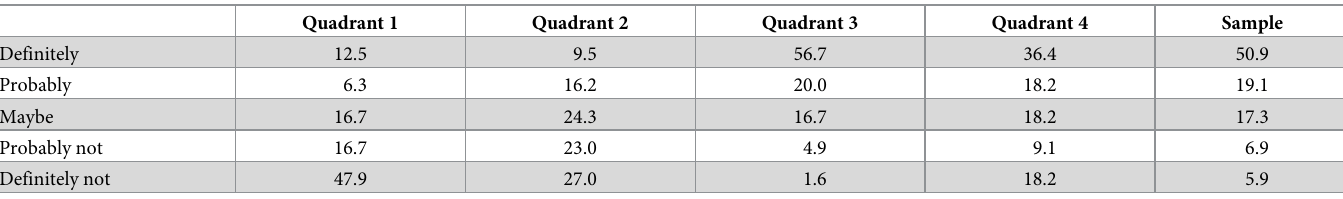
Table 4. I 3 vaccine classification and willingness to be vaccinated.